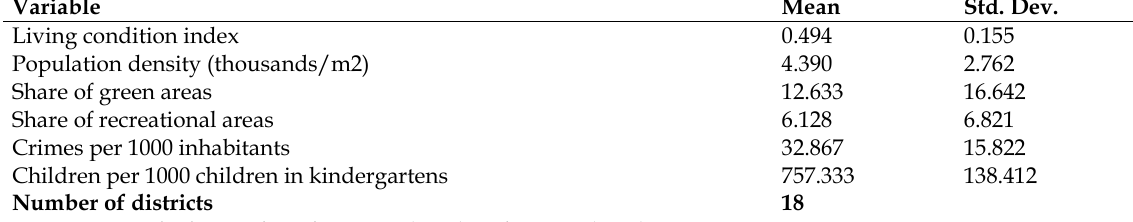
Summary statistics of neighborhood related